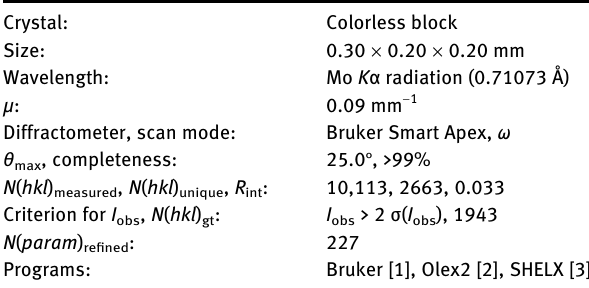
Table  : Data collection and